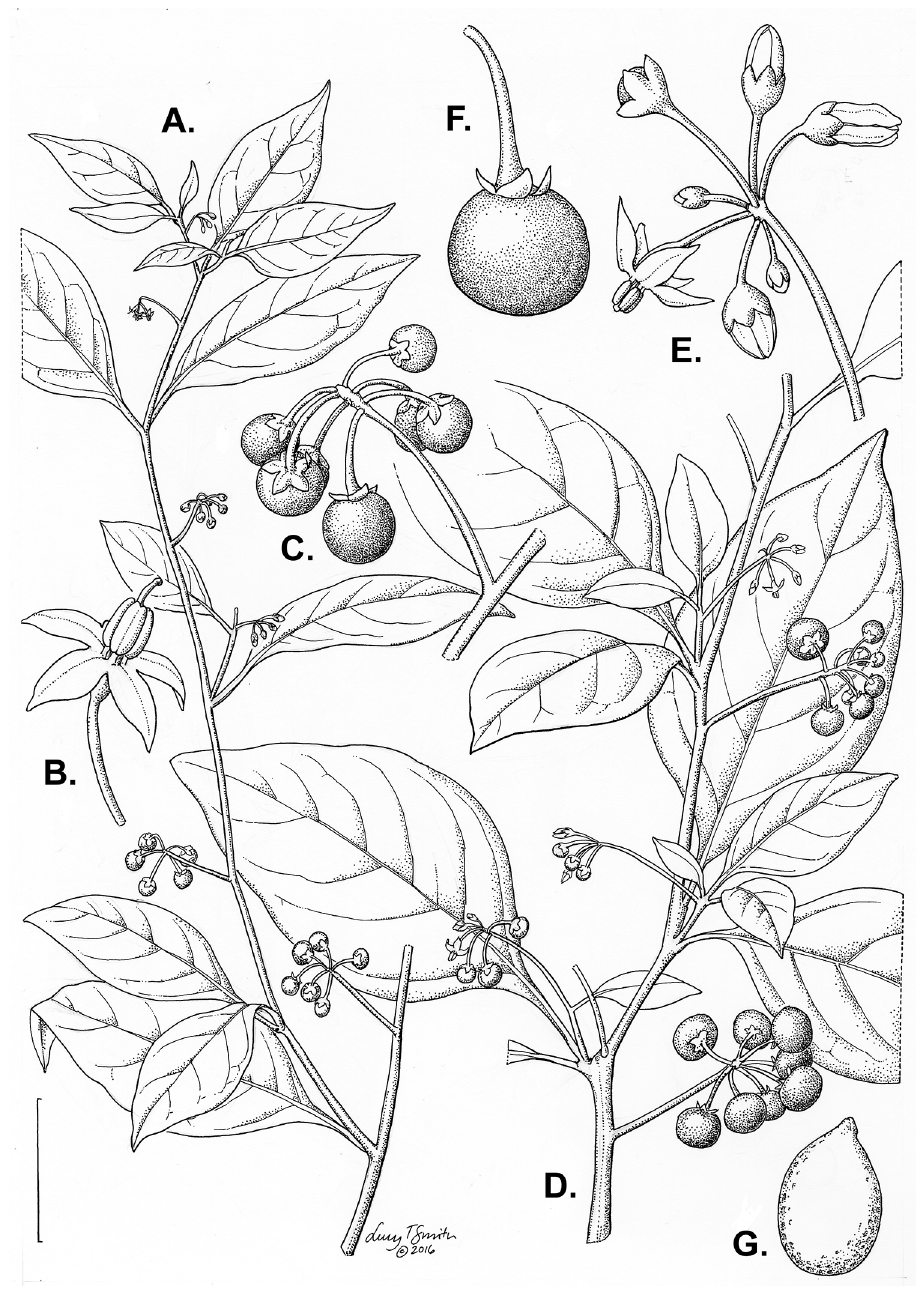
Figure 48. Solanum scabrum Mill. A Habit of wild form B flower of wild form C infructescence of wild form D habit of cultivated form E inflorescence of cultivated form F fruit of cultivated form G seed ( A–C Pilz 2108 ; D-G Nee 16088 ). Scale bars: 4 cm ( A, D ); 3.3 mm ( B ); 1.5 cm ( C, F ); 7 mm ( E ); 2 mm ( G ). Drawing by L. Smith (previously published in “PhytoKeys